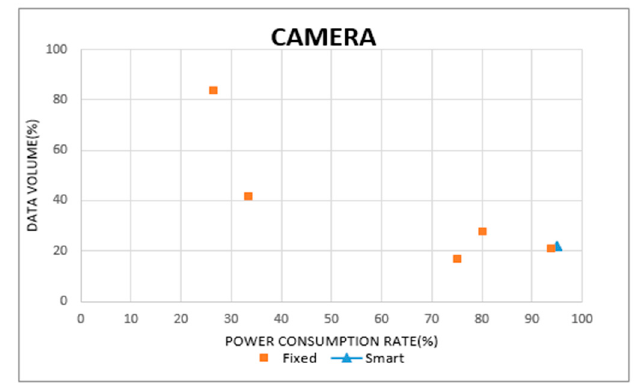
Figure 20. Sensing data volume in camera sensor.